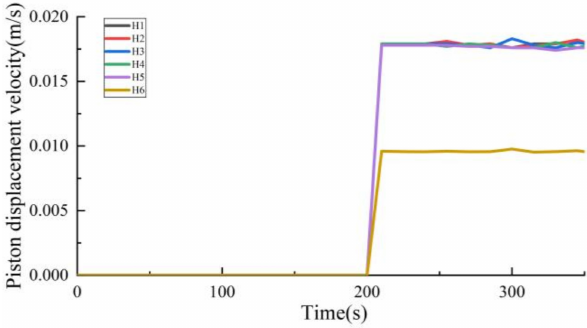
Figure 18. Piston speed of different leakage clearance.